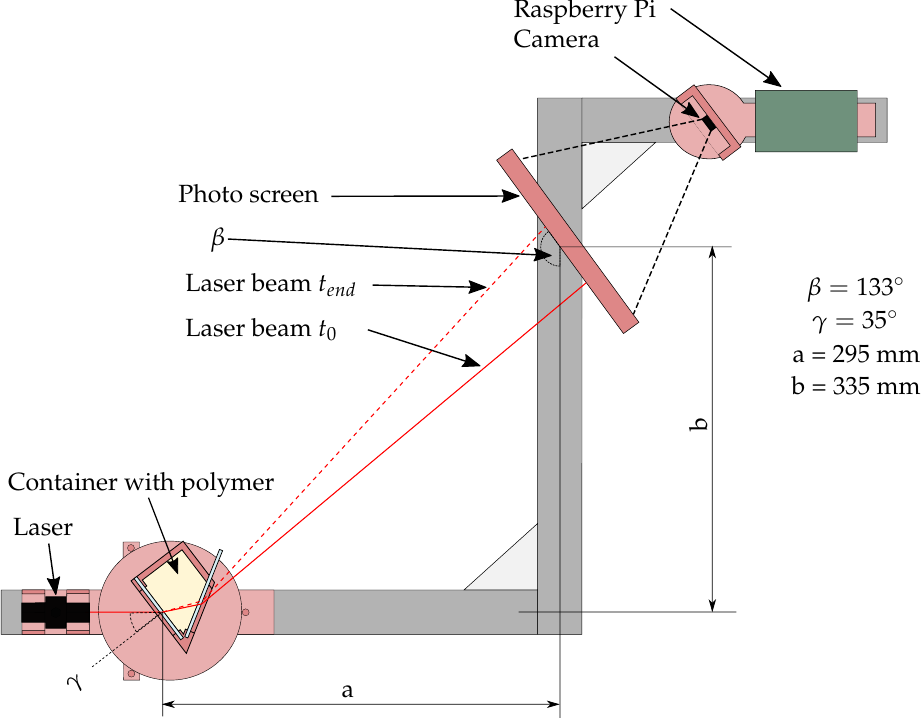
Figure 2. Schematic sketch which illustrates the path of the laser beam through the prism, the ar- rangement of the photo screen and camera perspective (top view).